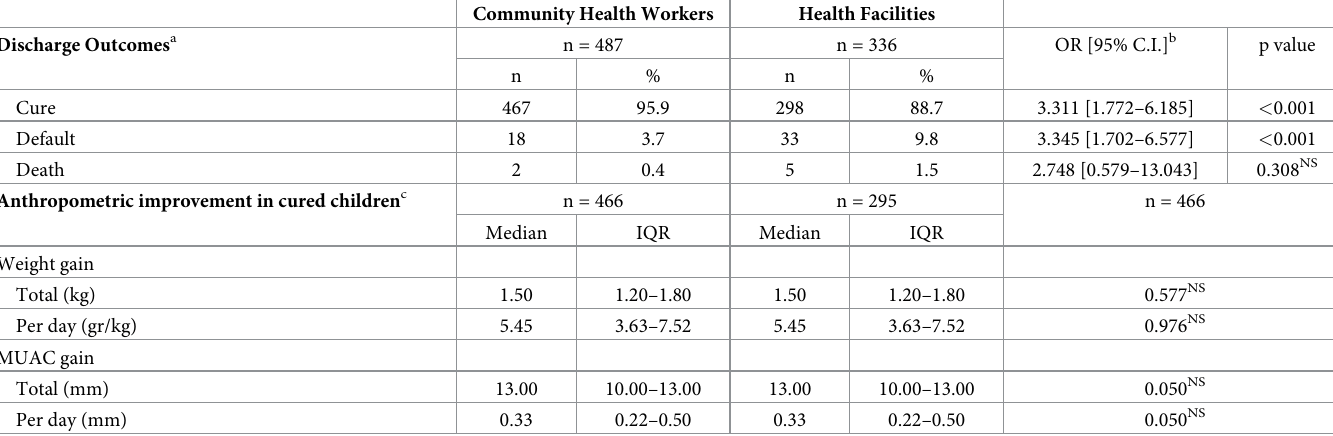
Table 3. Treatment outcomes considering the two models of severe acute malnutrition outpatient management.